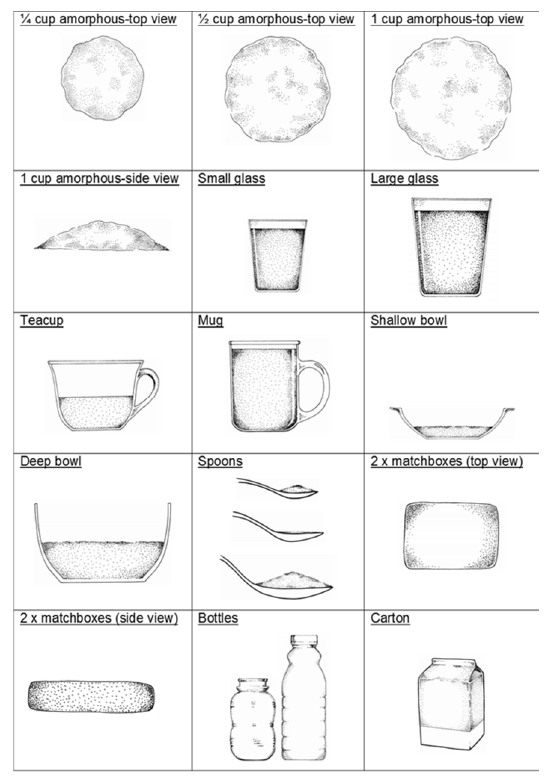
Figure 1. Examples of sketches and measures used in the study.